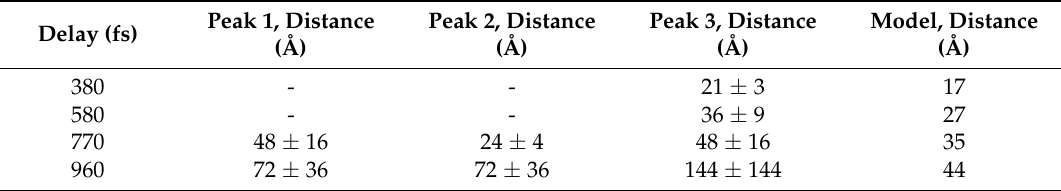
Table 1. Fragment distances calculated based on the transient peak shifts in the Auger electron spectra and a Coulomb interaction. The confidence intervals are calculated assuming a constant error in relative peak position of 0.1 eV. For comparison, the expected distances under the model assumption of one-dimensional fragmentation that the entire absorbed excess energy is transformed into kinetic energy are